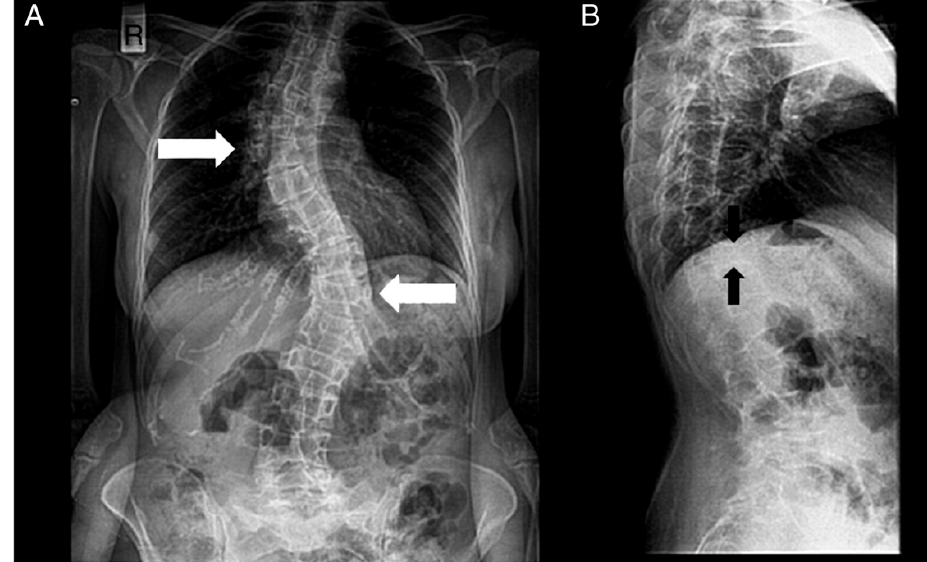
Figure 5. Radiographs of a patient’s spine. ( A ) Anteroposterior view. ( B ) Lateral view. The following are noted: scoliosis (double major—with a right thoracic and a left thoracolumbar curve—white arrows), and biconcave deformities of the upper and lower endplate (fishbone deformity—black arrows) of many vertebrae and decreased bone